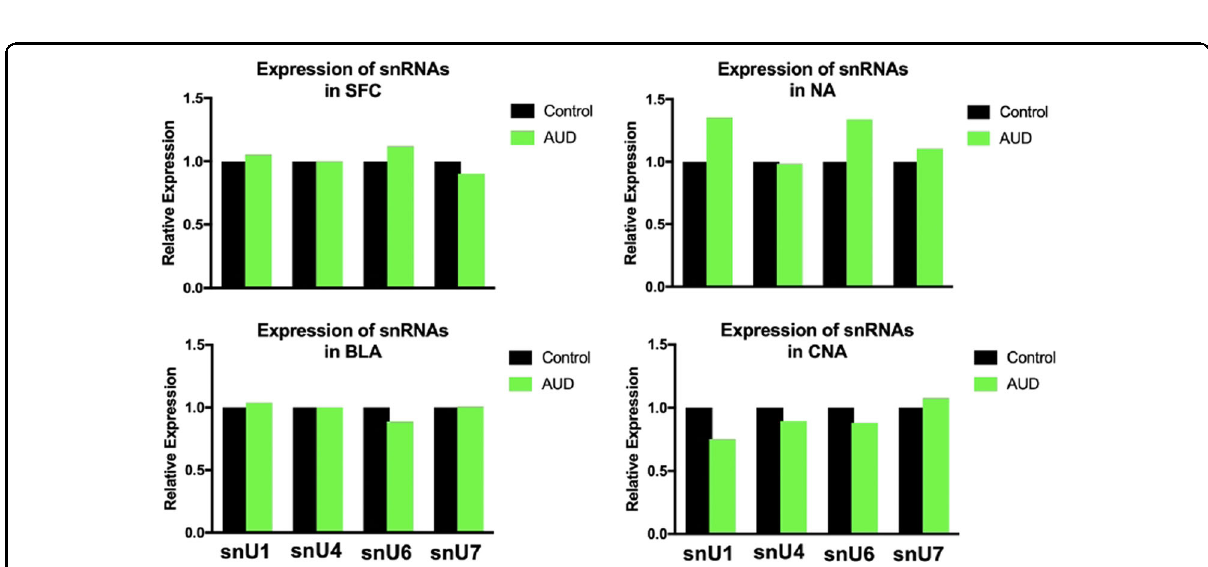
Fig. 3 Expression of small nuclear RNAs (snRNAs) in the brain in alcohol use disorder (AUD). SFC superior frontal cortex, NA nucleus accumbens, BLA basolateral amygdala, CNA central nucleus of the amygdala. Two-tailed Student ’ s t test was used to compare the expression of snRNAs between two groups within each region. To compare the means between multiple groups, we employed two-way ANOVA which allows testing for interactions between two